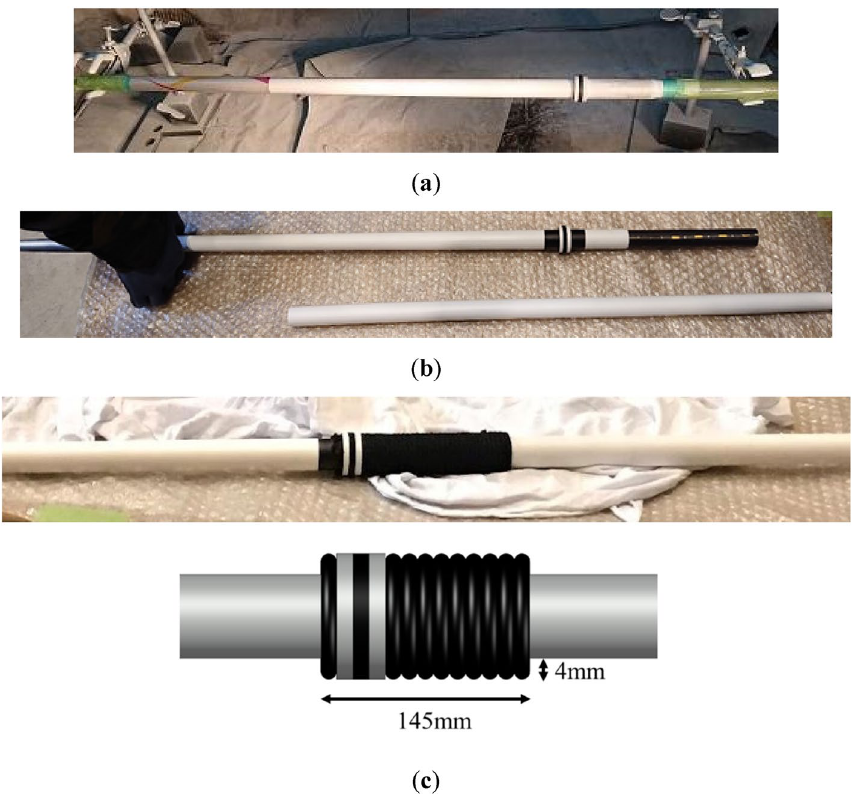
Figure 2. Commercially available women’s javelin: ( a ) The javelin was spray painted white and a 15 mm-long collar was attached to the javelin at the center of gravity; ( b ) Neodymium magnets were inserted along the longitudinal axis. ( c ) A 15 mm-long-collar and grip